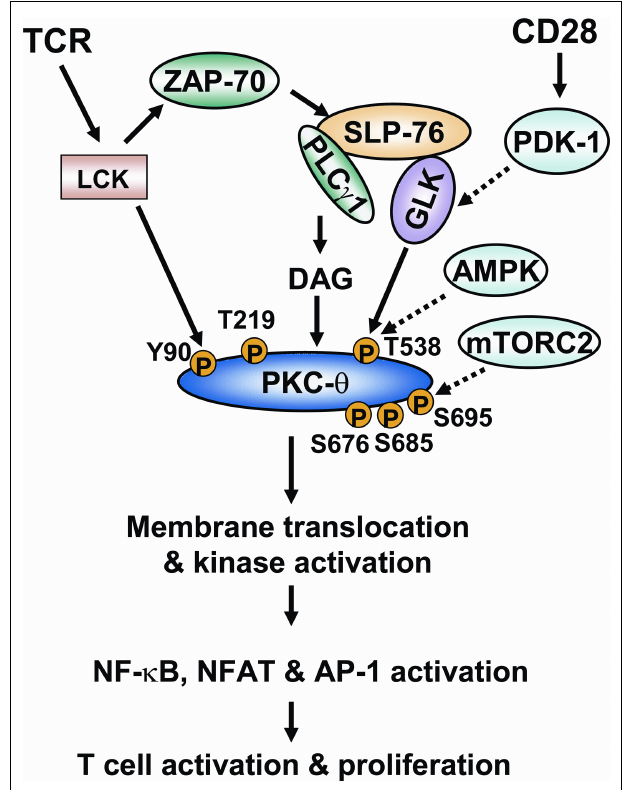
FIGURE 3 |The model of regulation of PKC- θ phosphorylation during TCR signaling. Ligation ofTCR induces the activation of tyrosine kinase LCK. LCK activates ZAP-70, which in turn induces tyrosine phosphorylation of the adaptor SLP-76. SLP-76 directly interacts with and activates PLC γ